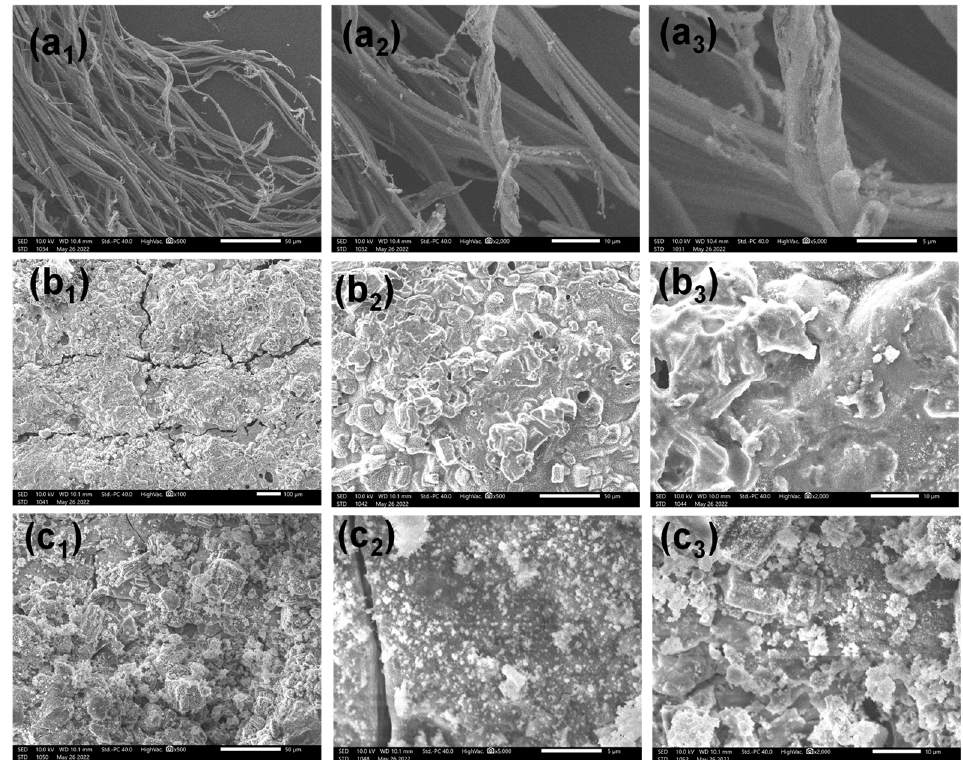
Figure 8. SEM images of char residues after flame exposure for 12 s of pristine cotton ( a 1 – a 3 ), CH/APP cotton ( b 1 – b 3 ), CH/APP@TiO 2 -SiO 2 -HMDS cotton ( c 1 – c 3 ).